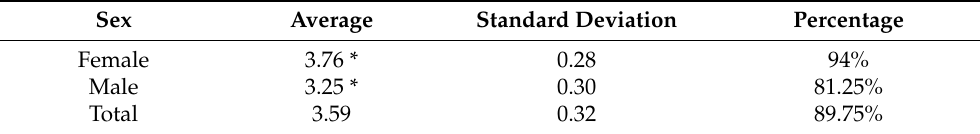
Table 4. Average and standard deviations from the overall results of the Zika virus questionnaire.